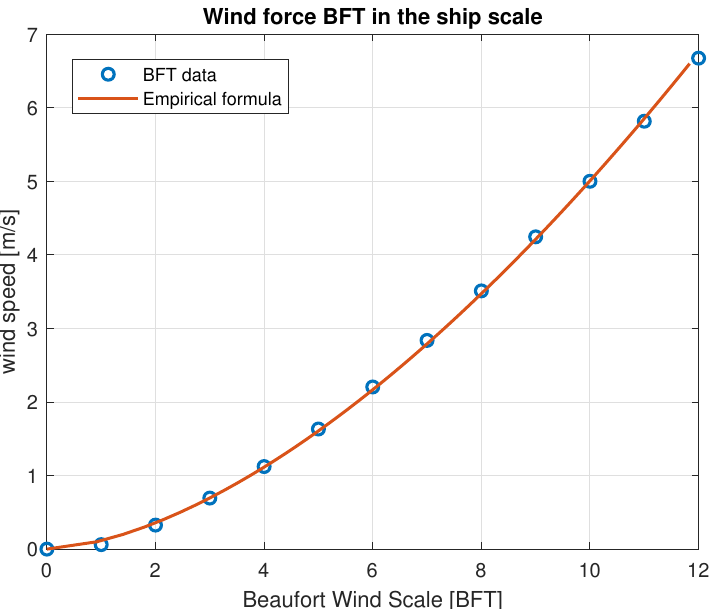
Figure 6. Conversion of wind speed to the BFT (Beaufort Wind Scale) in the ship model scale.